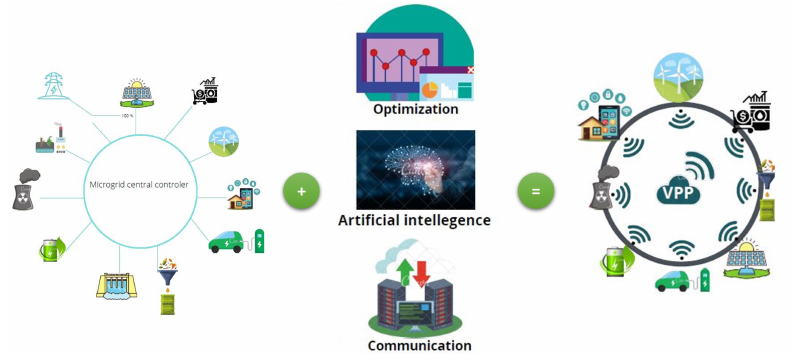
Figure 1. Evolution of MG to